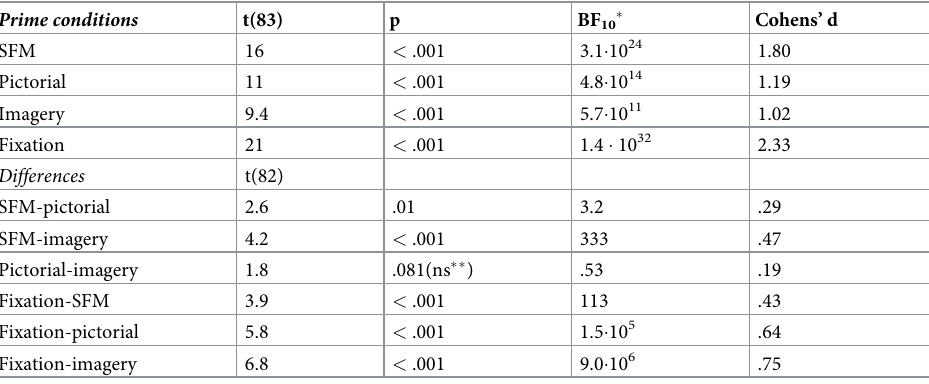
Table 1. Influence of primes and differences between primes in Experiment 1.